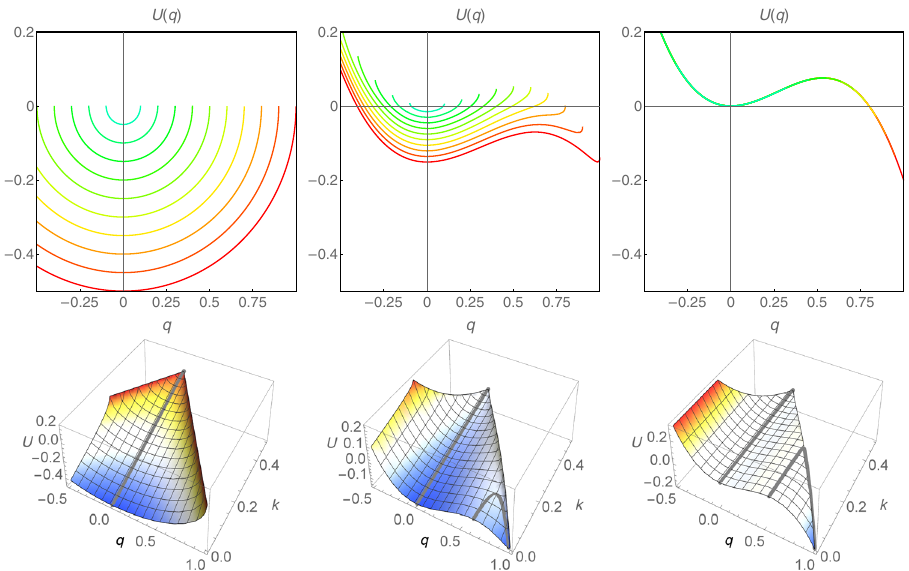
≈ 0 . 698 , the zero- QPT